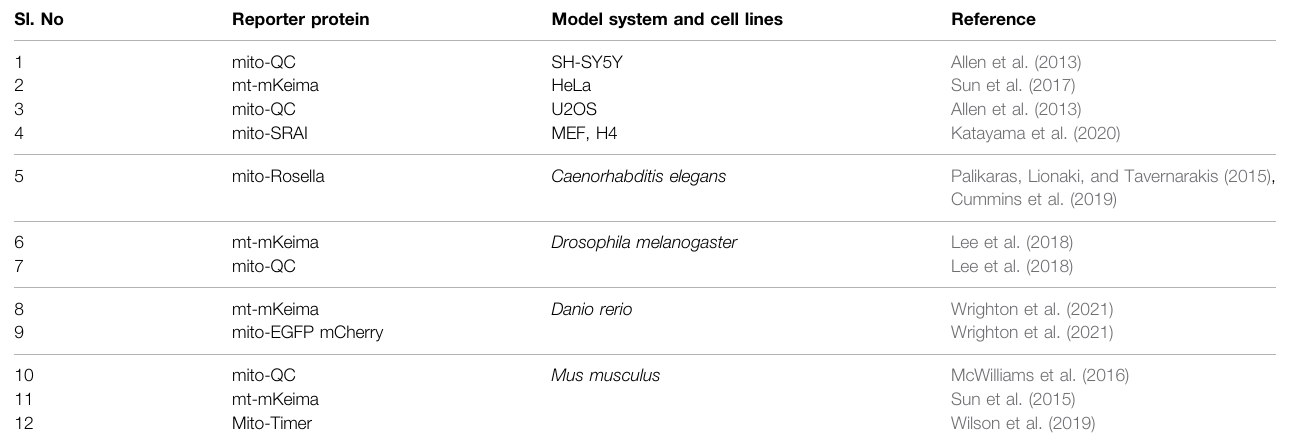
TABLE 1 | Reporter proteins and model systems used to study mitophagy. Sl.